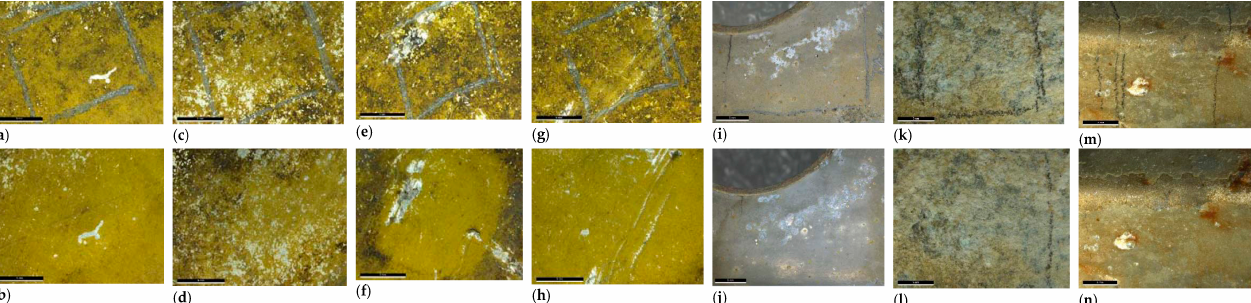
Figure 6. Results of gel treatments on the fragment from a Messerschmitt Bf109: before ( a ) and after treatment using agar with citric acid (0.055 M) ( b ), before ( c ) and after treatment using agar with TAC ( d ), before ( e ) and after treatment using xanthan with metasilicate sodium ( f ), before ( g ) and after treatment using xanthan with tetra-EDTA ( h ) (© S. Bampitzaris/Arc’Antique—Grand Patrimoine de Loire Atlantique, Nantes, France). Results of gel treatments on the wing part from a Spitfire Mk VII MB887: before ( i ) and after treatment using agar with TAC ( j ), before ( k ) and after treatment using xanthan with metasilicate sodium ( l ), before ( m ) and after treatment using xanthan with tetra-EDTA ( n ) (© E. Paillaux/Arc’Antique—Grand Patrimoine de Loire Atlantique, Nantes, France).